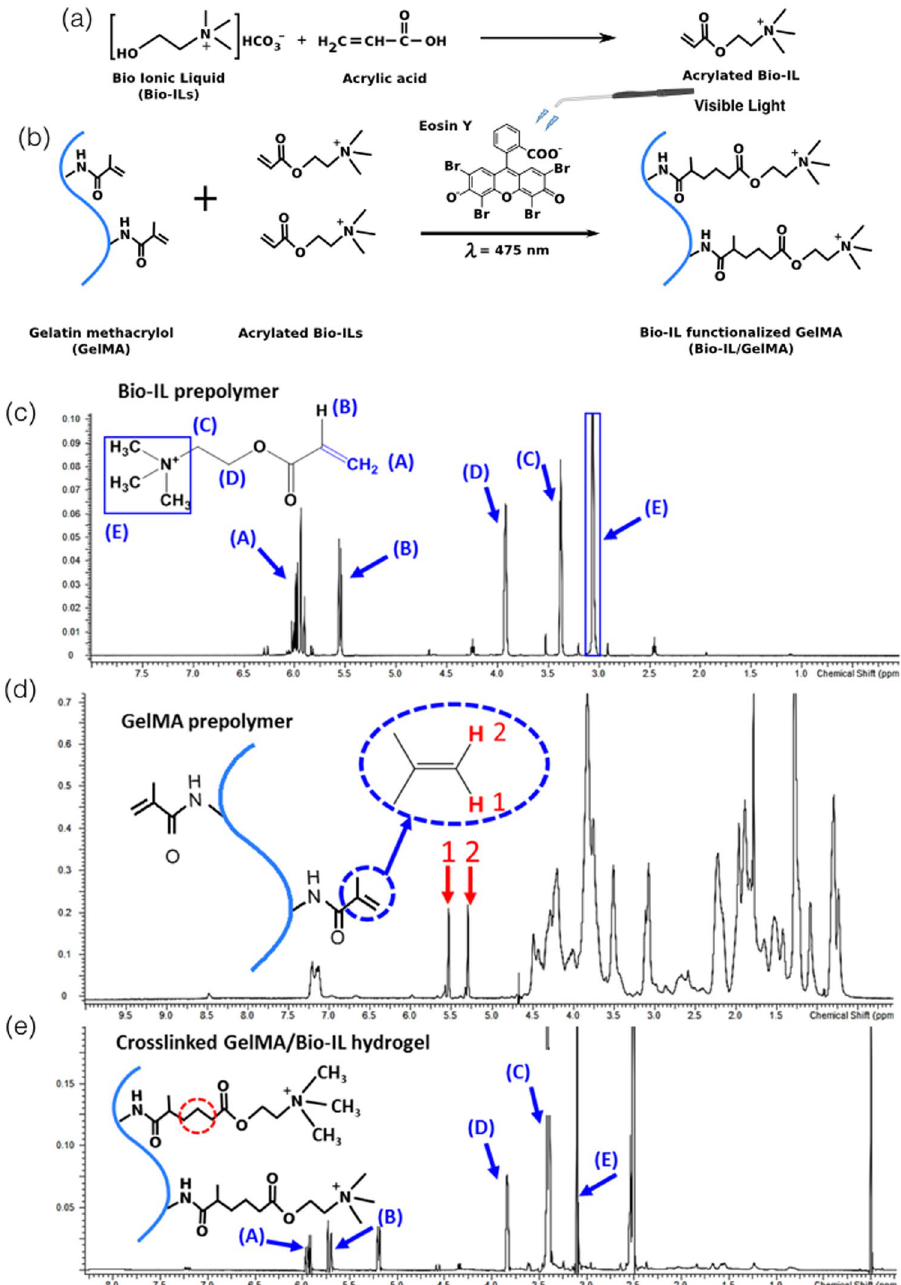
Figure 1. Synthesis and characterization of Bio-IL functionalized GelMA hydrogels. The panels show schematics of the proposed reactions for ( a ) the acrylation of choline bicarbonate to form Bio-IL, and ( b ) the reaction between GelMA and Bio-IL in the presence of Eosin Y and visible light to form GelMA/Bio-IL hydrogel. 1 H-NMR analysis of ( c ) Bio-IL prepolymer, ( d ) GelMA prepolymer, and ( e ) GelMA/Bio-IL composite hydrogel. GelMA/Bio-IL hydrogels were formed by using 1% VC, 1.5% TEOA, and 0.1 mM Eosin Y at 120 s light